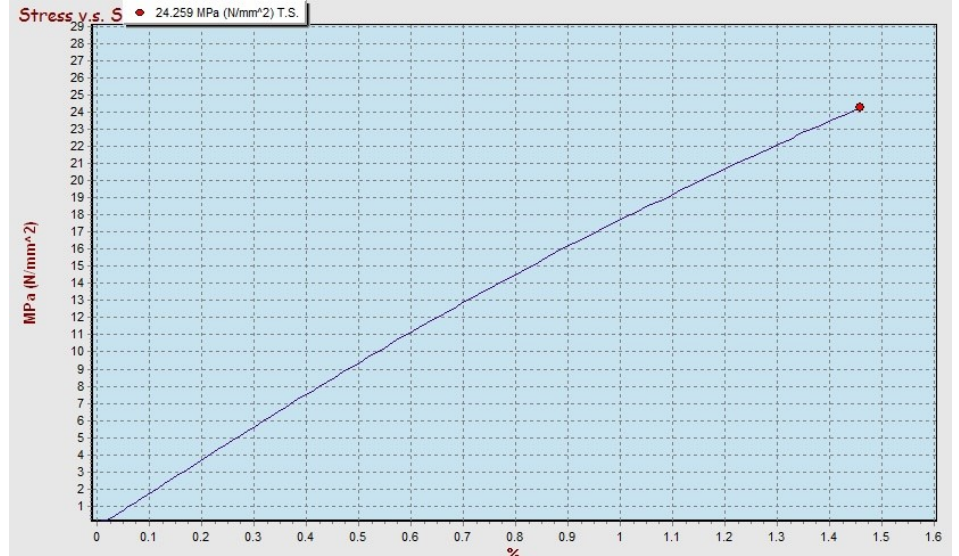
Figure 11. Stress–strain relationship in the tensile test of UPR–SBT composite with 30 vf% and 250 mesh particle size.